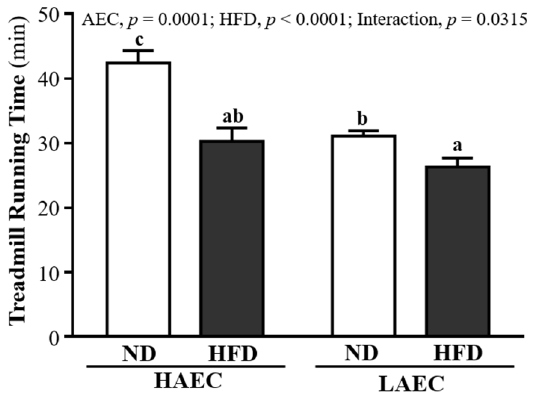
Figure 2. Effects of 12 weeks’ HFD feeding of HAEC or LAEC postpartum mice on endurance treadmill running test. Data are mean ± SEM for n = 8 mice per group. Columns with different superscript letters (a, b, c) are significantly different at p < 0.05.